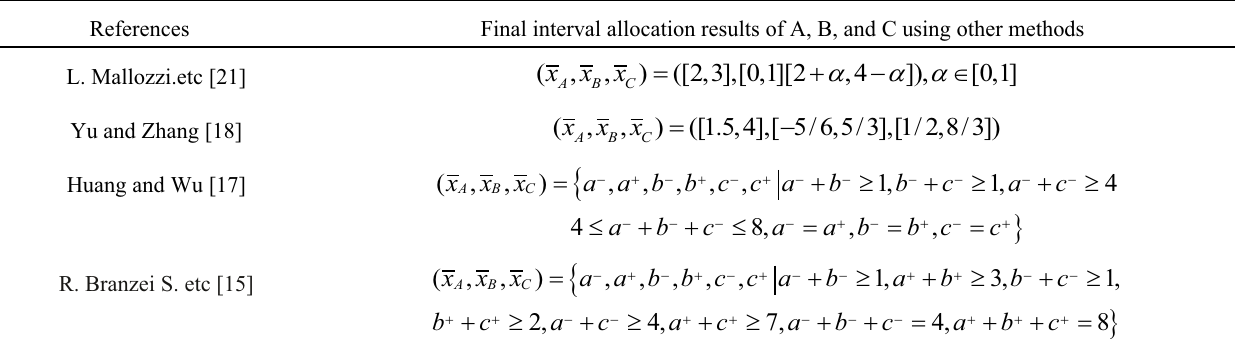
Table 5 Allocation results when compared with other